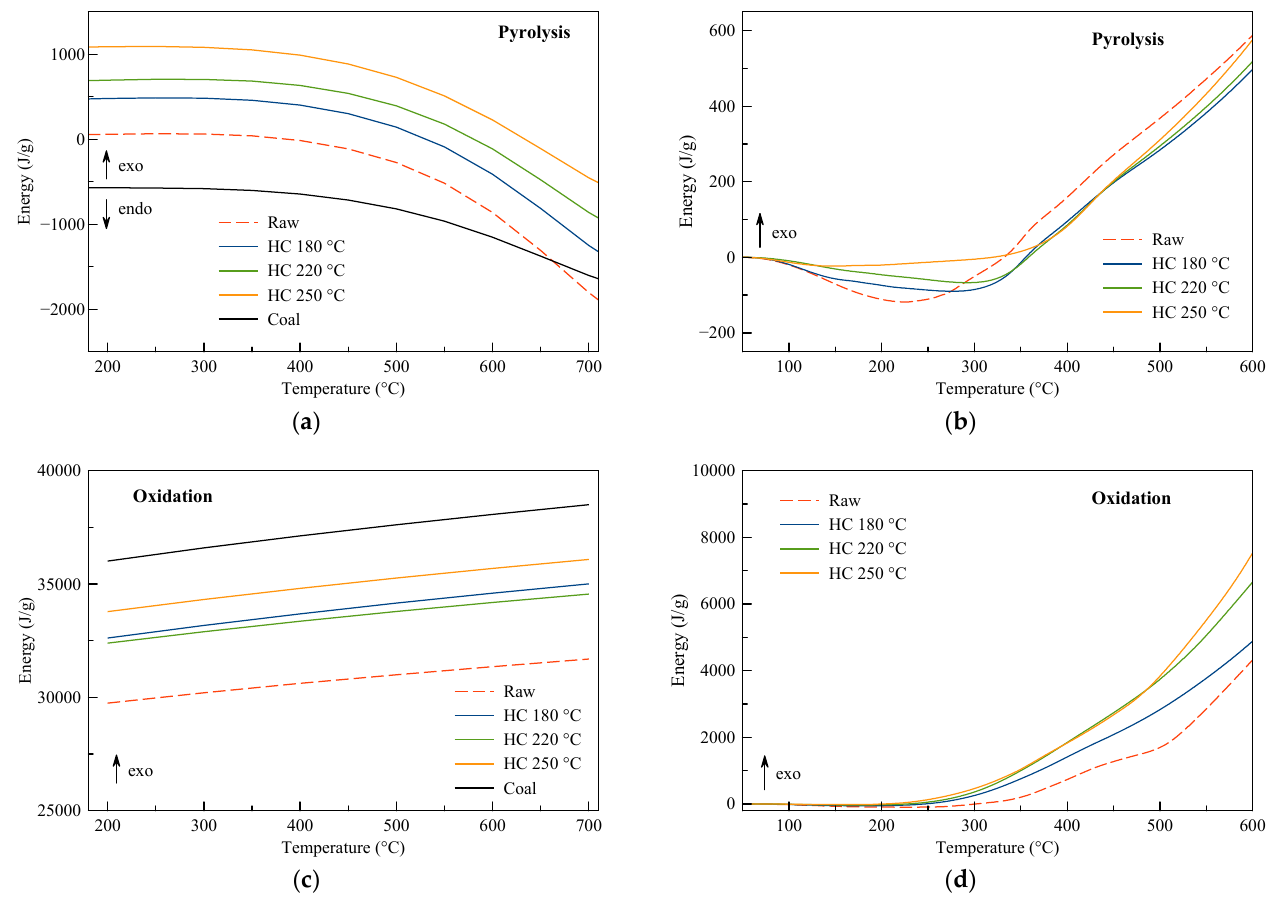
Figure 8. Energy released (> 0) or absorbed (< 0) by the samples computed from: ( a ) Aspen Plus during pyrolysis; ( b ) DSC data during pyrolysis at 10 °C/min; ( c ) Aspen Plus during oxidation; ( d ) DSC data during oxidation at 10 °C/min; per grams of dry feedstock.